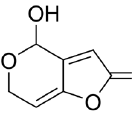
Figure 1: Chemical structure of